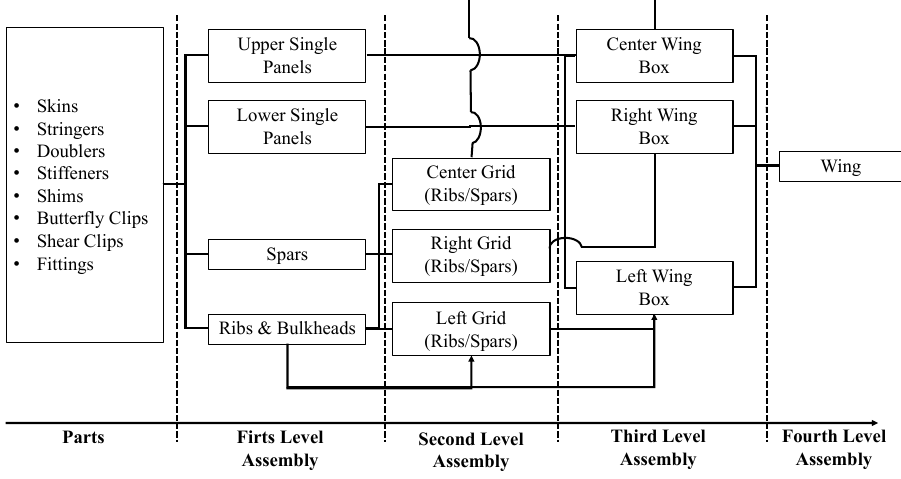
Figure 2. Wing flow assembly, adapted from Diez-Olivan [15].